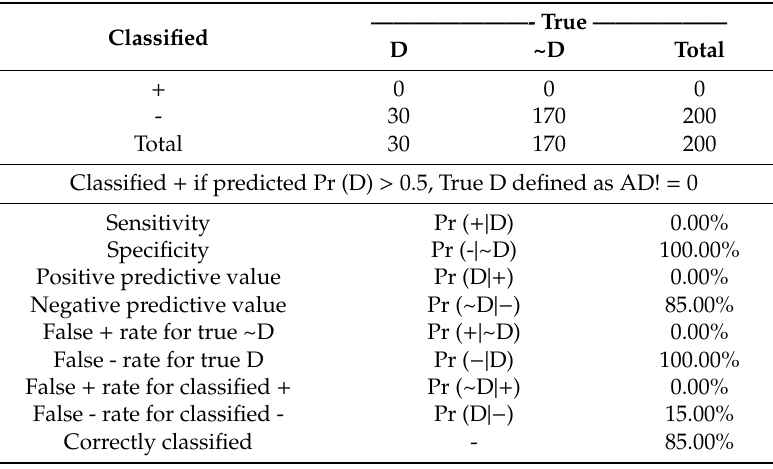
Table 8. Sensitivity and specificity for